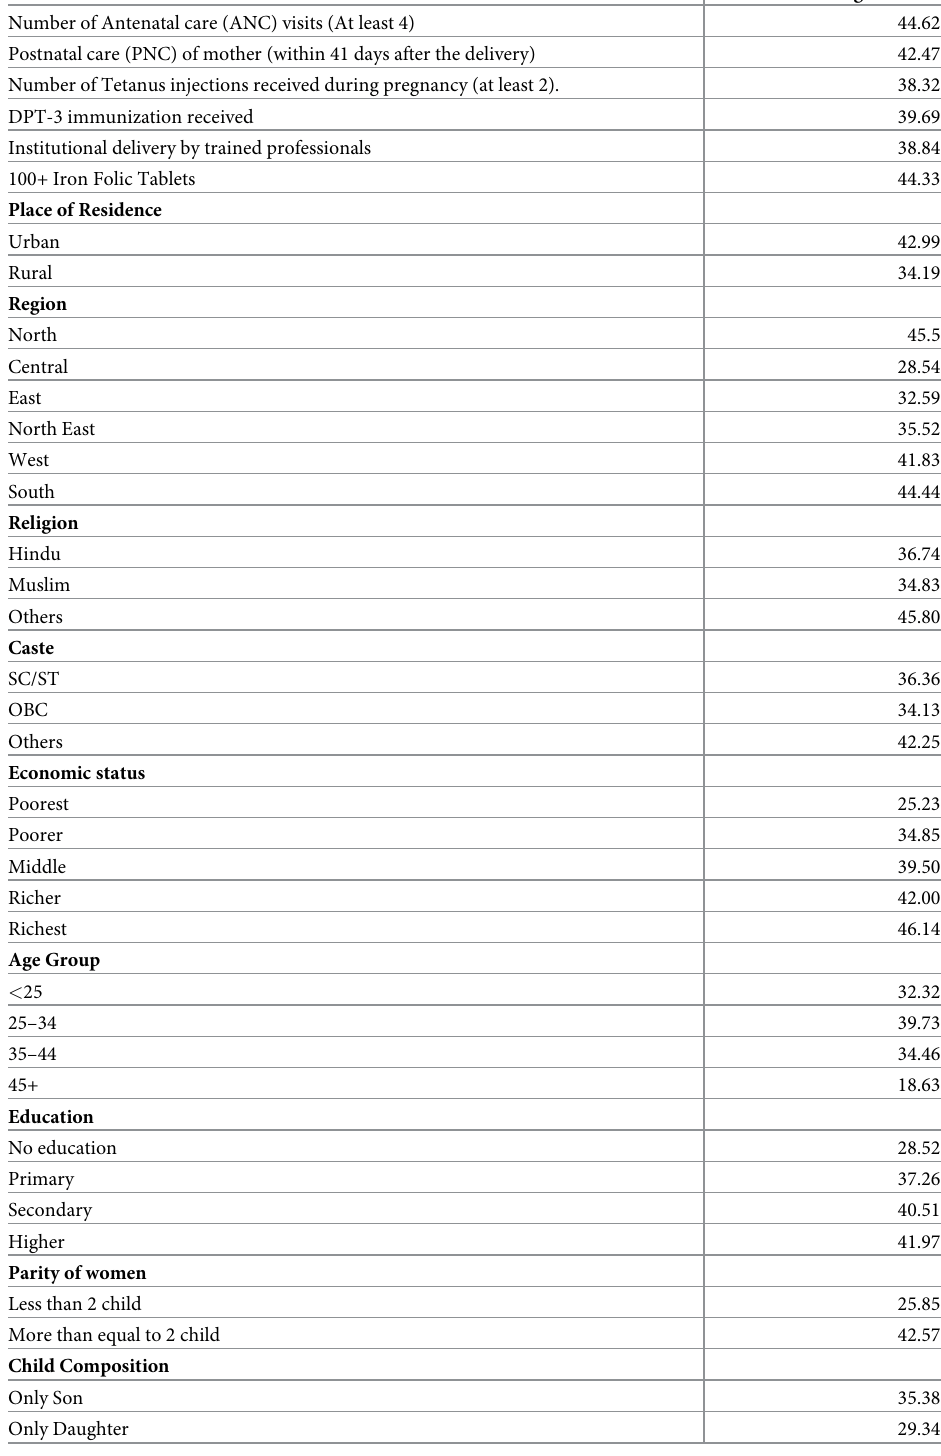
Table 3. Percentage distribution of contraceptive use after having recent birth by MCH care and socio-demo- graphic variables. Maternal and Child care Percentage Number of Antenatal care (ANC) visits (At least 4) 44.62 Postnatal care (PNC) of mother (within 41 days after the delivery) 42.47 Number of Tetanus injections received during pregnancy (at least